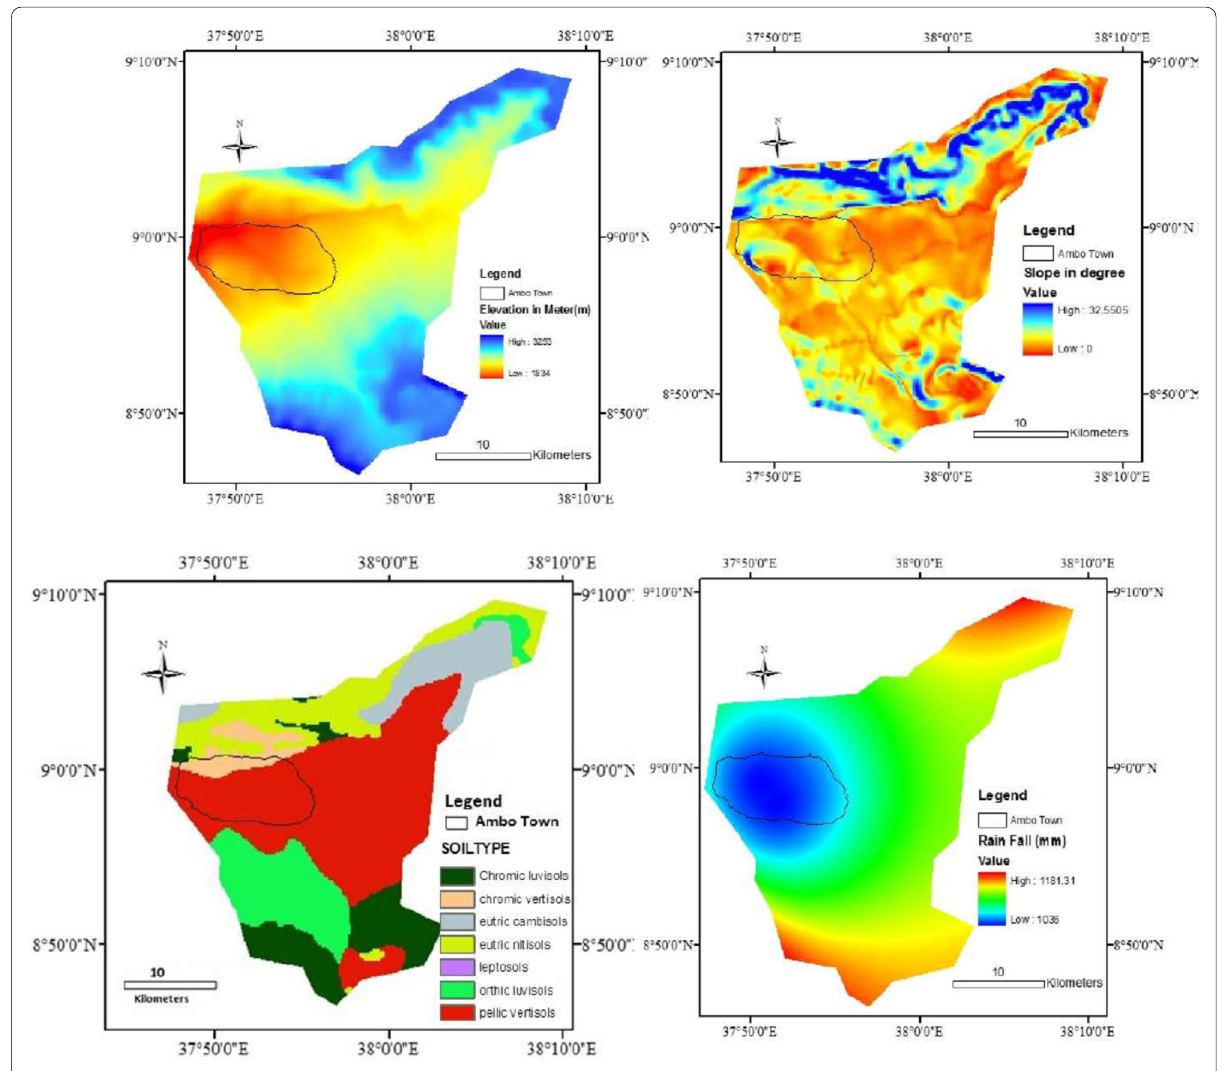
Fig. 3 Elevation, slope, soil type, and rainfall distribution of Huluka